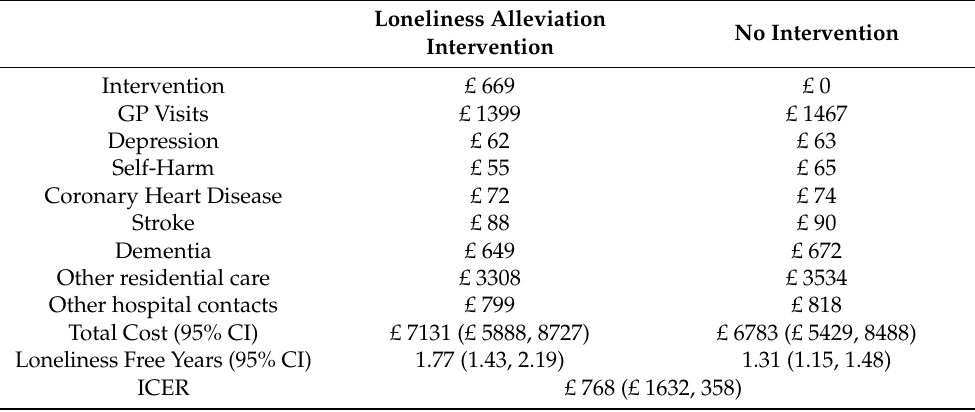
Table 2. Summary of cost-effectiveness findings (health and social care perspective).